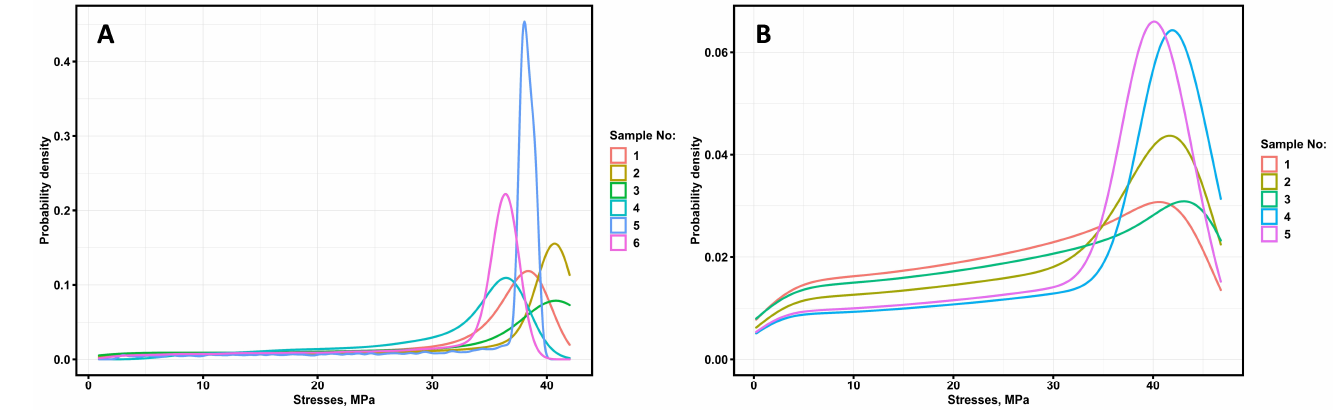
Figure 4. Fracture probability density functions of the 60Al 2 O 3 /40PLA filaments ( A ) and printed samples ( B ).